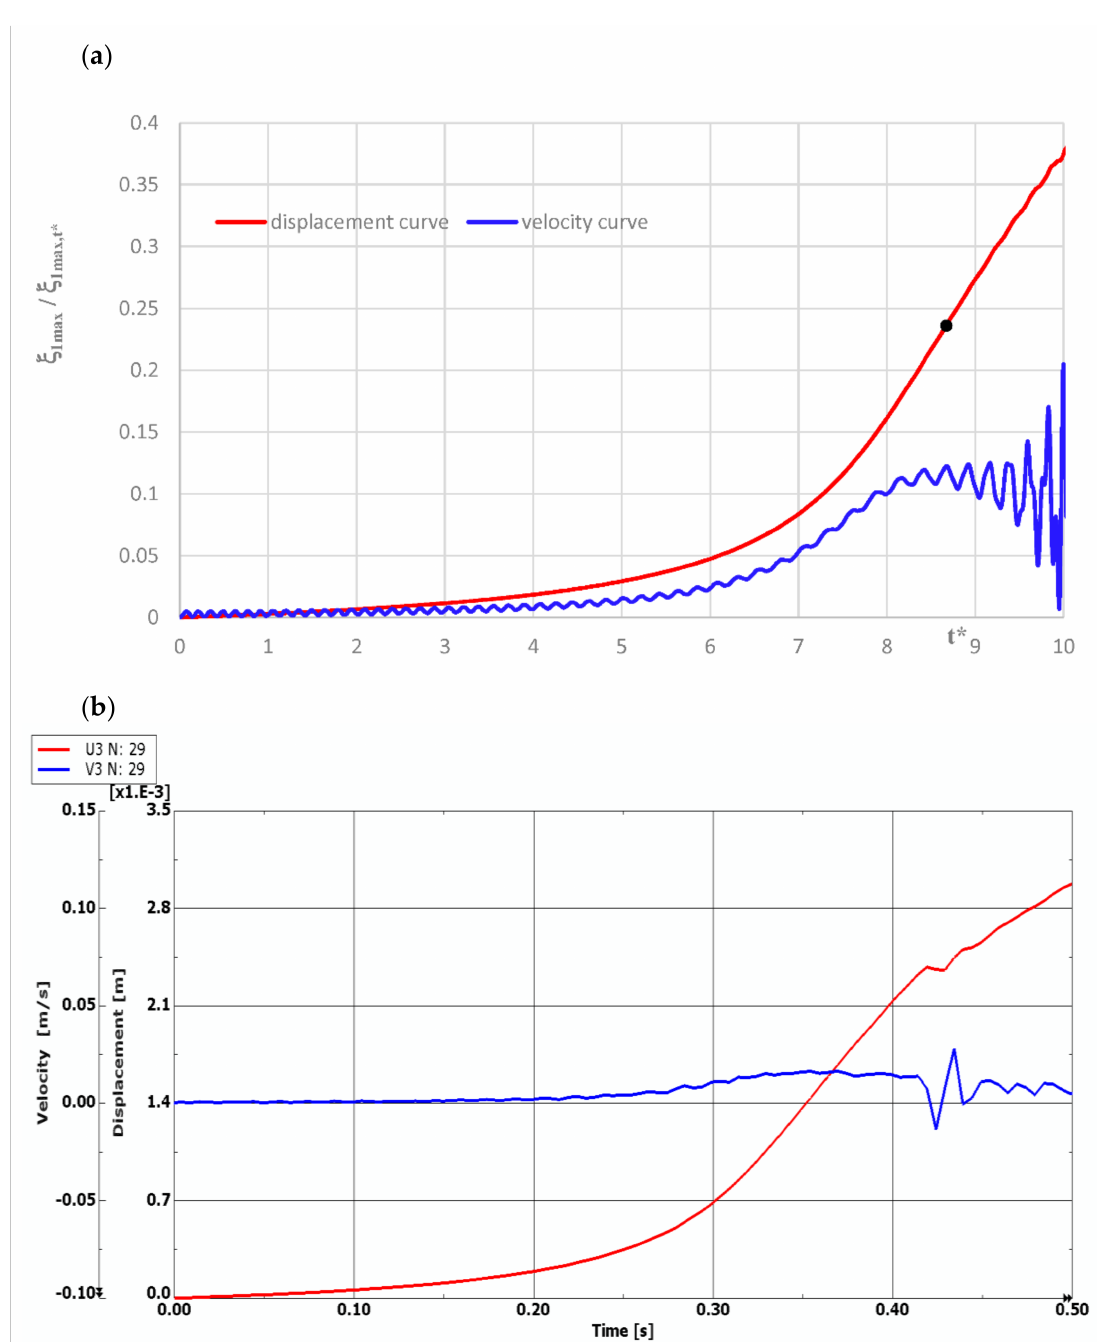
Figure 8. Time histories of deflection and velocity of deflection of quasi-isotropic plate with undamaged facings represented by ( a ) FDM model, ( b ) FEM